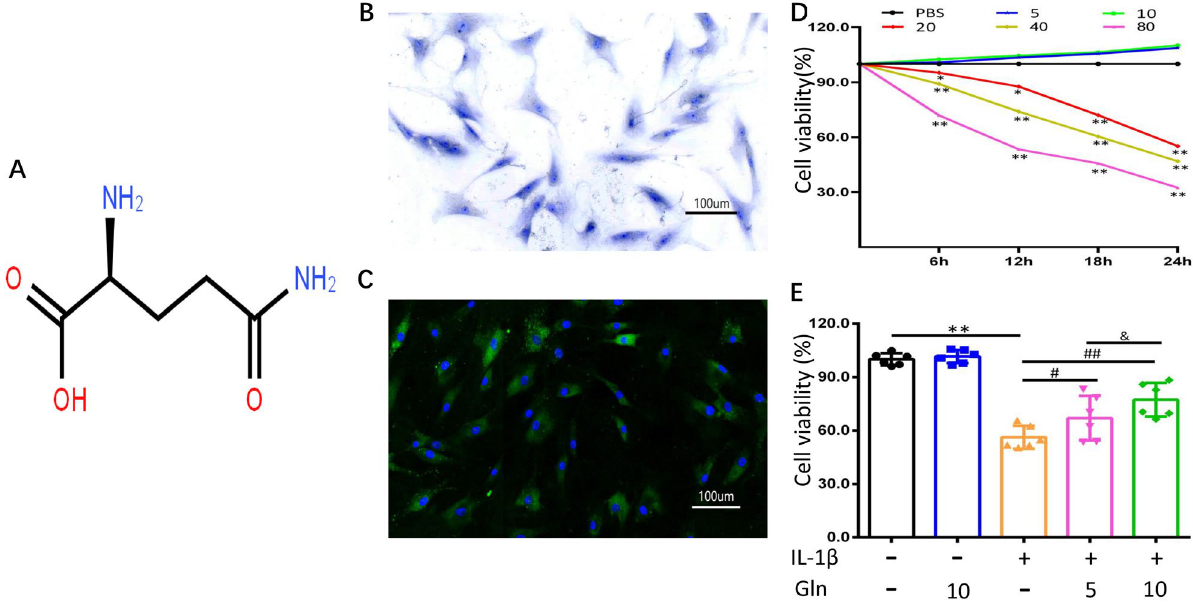
Figure 1. ( A ) Molecular structure of glutamine is shown. ( B , C ) Identification of human primary chondrocytes. Picture ( B ) shows the morphological characteristics of human primary chondrocytes using toluidine blue staining. The chondrocytes were stained green by collagen II immunofluorescence staining, and the nuclei were stained blue by DAPI. ( D ) Effect of glutamine on human primary chondrocyte viability. Human primary chondrocytes were cultured in 96-well plates and then treated with different concentrations of glutamine (5, 10, 20, 40, or 80 μmol/l) for 24 h. ( E ) Human primary chondrocytes were pretreated with both doses of glutamine (5, 10 μmol/l) for 2 h and then induced with IL-1β (10 ng/ml) for 24 h. All data are presented as the M ± SEM (n = 6 in each group). *p < 0.05 vs. IL-1β(−) and Gln(−) group, **p < 0.01 vs. IL-1β(−) and Gln(−) group; # p < 0.05 vs. IL-1β(+) and Gln(−) group, ## p < 0.01 vs. IL-1β(+) and Gln(−) group; & p < 0.05 vs. IL-1β(+) and Gln(5) group, && p < 0.01 vs. IL-1β(+) and Gln(5) group by